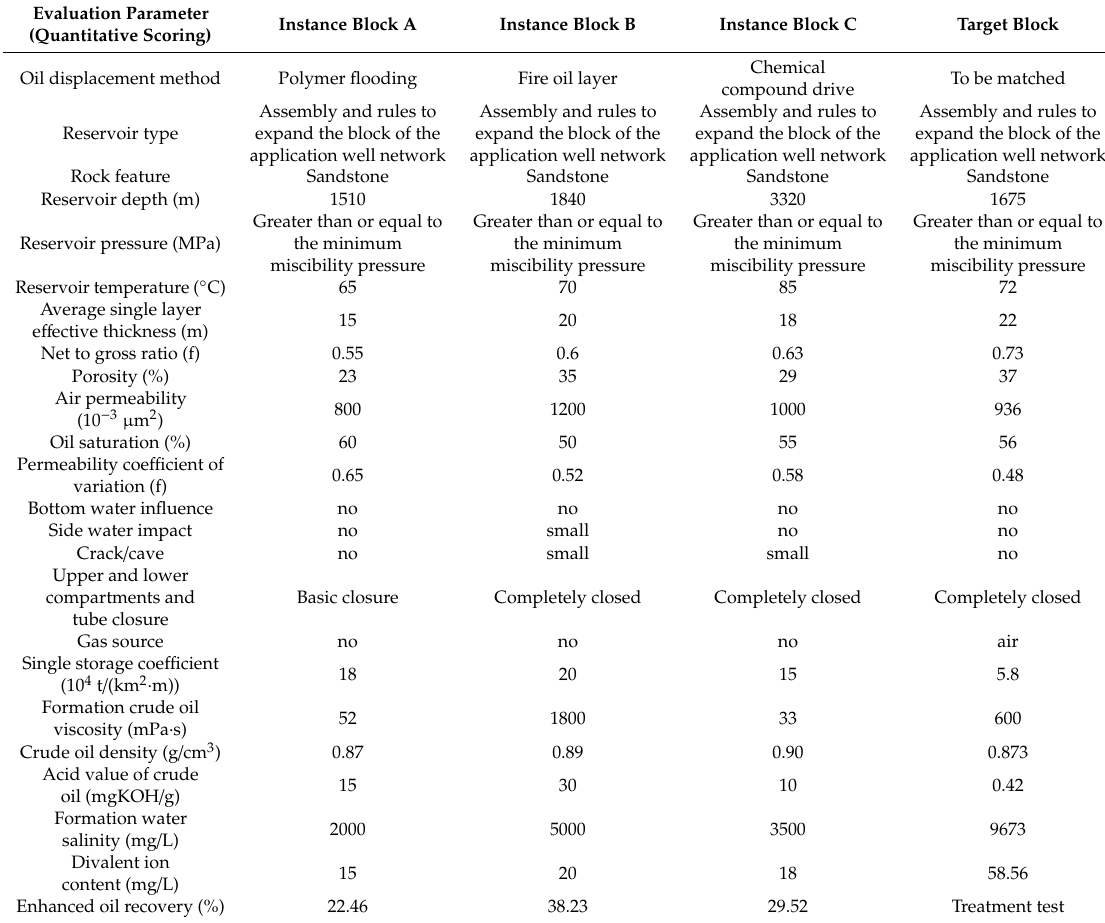
Figure 1. Flow chart of the software operation. The software interface adopts the combination of the switching function window and the pop-up association window in the main window, that is, the upper main menu, the lower left navigation bar, and the lower right function window.4.2. Case Analysis. Table 2. Analytical data of the